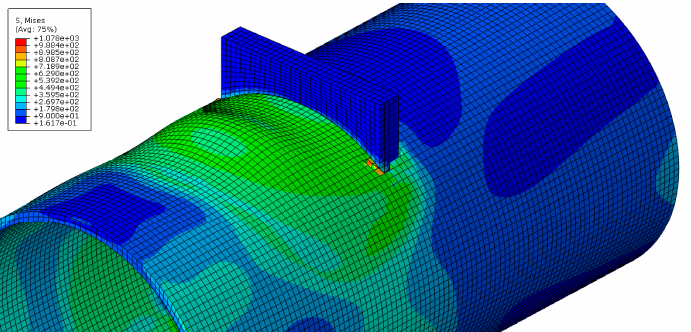
Figure 8. von Mises stress distribution of the tube under localised transverse compression (3D view, Case 10).